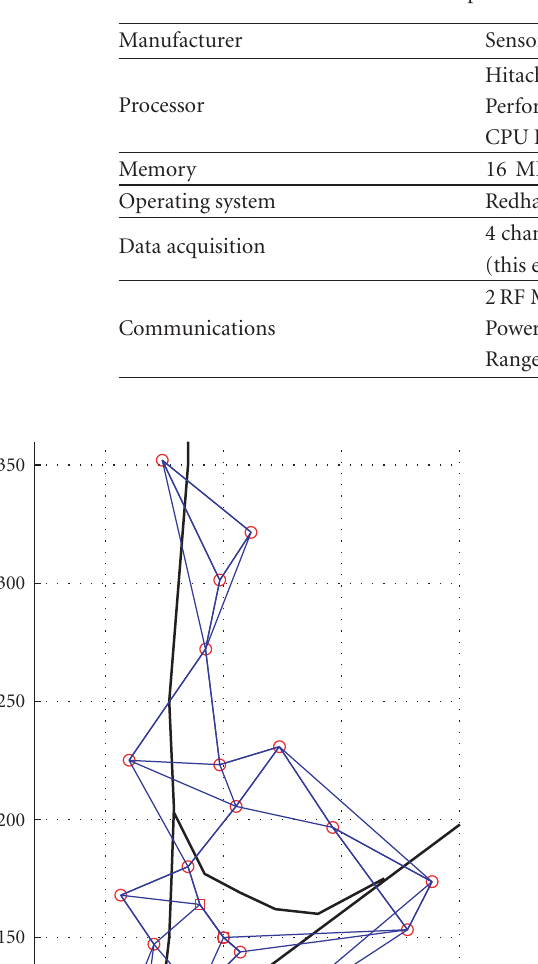
Table 5: Specification of Sensoria nodes.